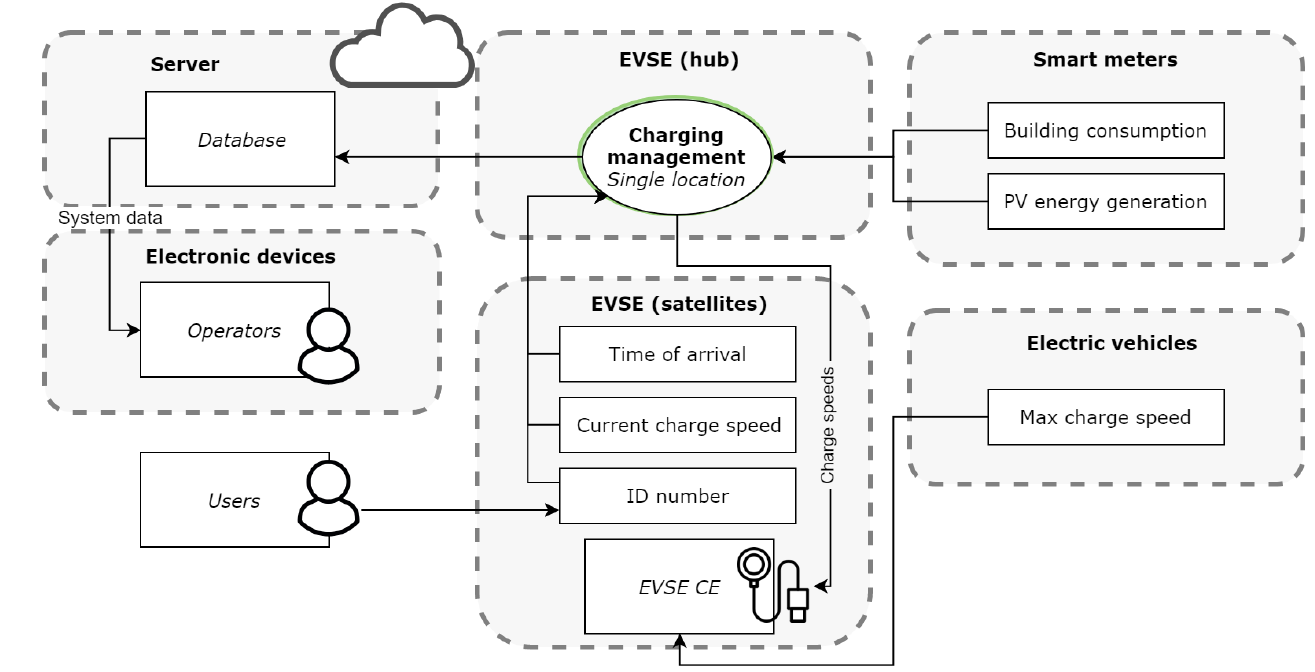
Figure 13. Function allocation to different parts of the short-term system. The back-office manages the database and runs on a server. The hub EVSE manages charging speeds for itself and all its satellite EVSE. Note that some of the static data in Figure 12 such as the contracted power and number of charging points are omitted. These do not change and can simply be set once when the system is